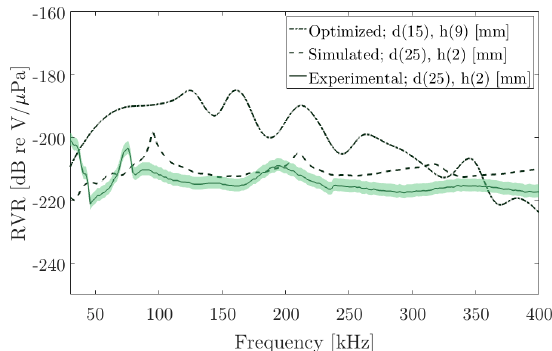
Figure 10. Receiving Voltage Response (RVR) for the piezoelectric ceramic PIC255 with diameter 25 mm and thickness 2 mm measured in the laboratory (solid line) together with its simulation (dotted line), the green area represents the standard deviation in the measurements. The optimized geometry shows a significant increase in the low-frequency band around 110 kHz.